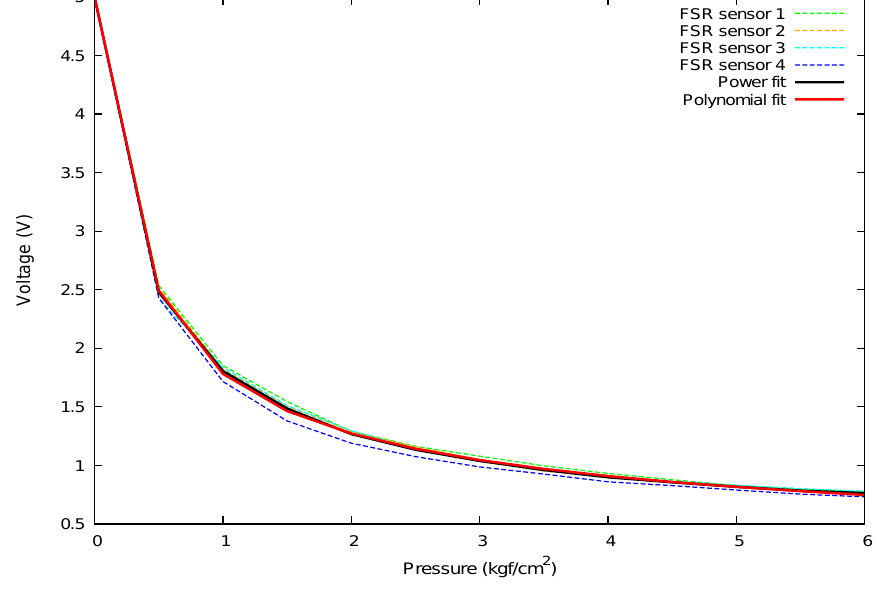
Figure 6. Calibration response of 4 FSR sensors and results for polynomial and power